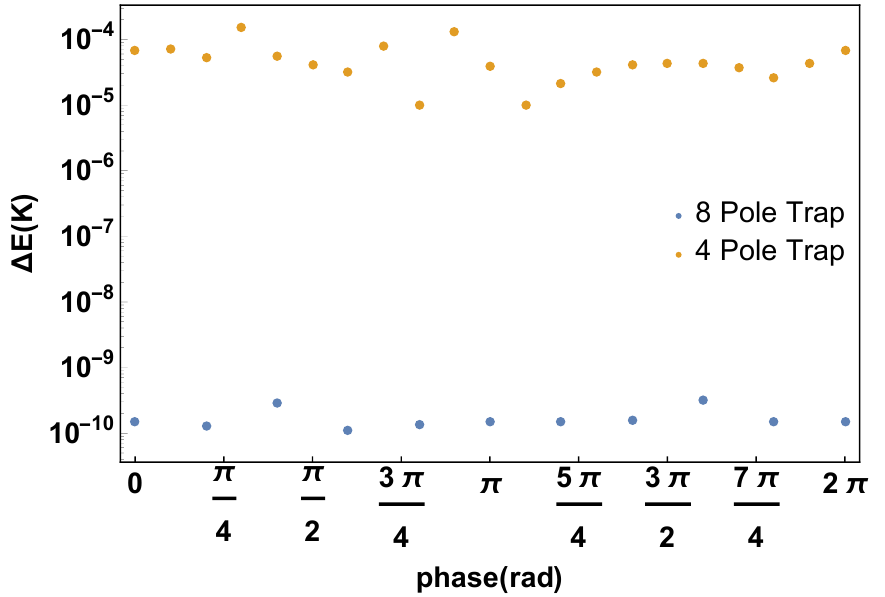
Figure 3. The change in the energy of the Ca ion–atom system, initially at rest, with the ion at the trap center post collision is presented. The results for the quadrupole and octopole trap configurations are shown. The energy gained is plotted against the phase of the electric field at the time of ion–atom’s closest